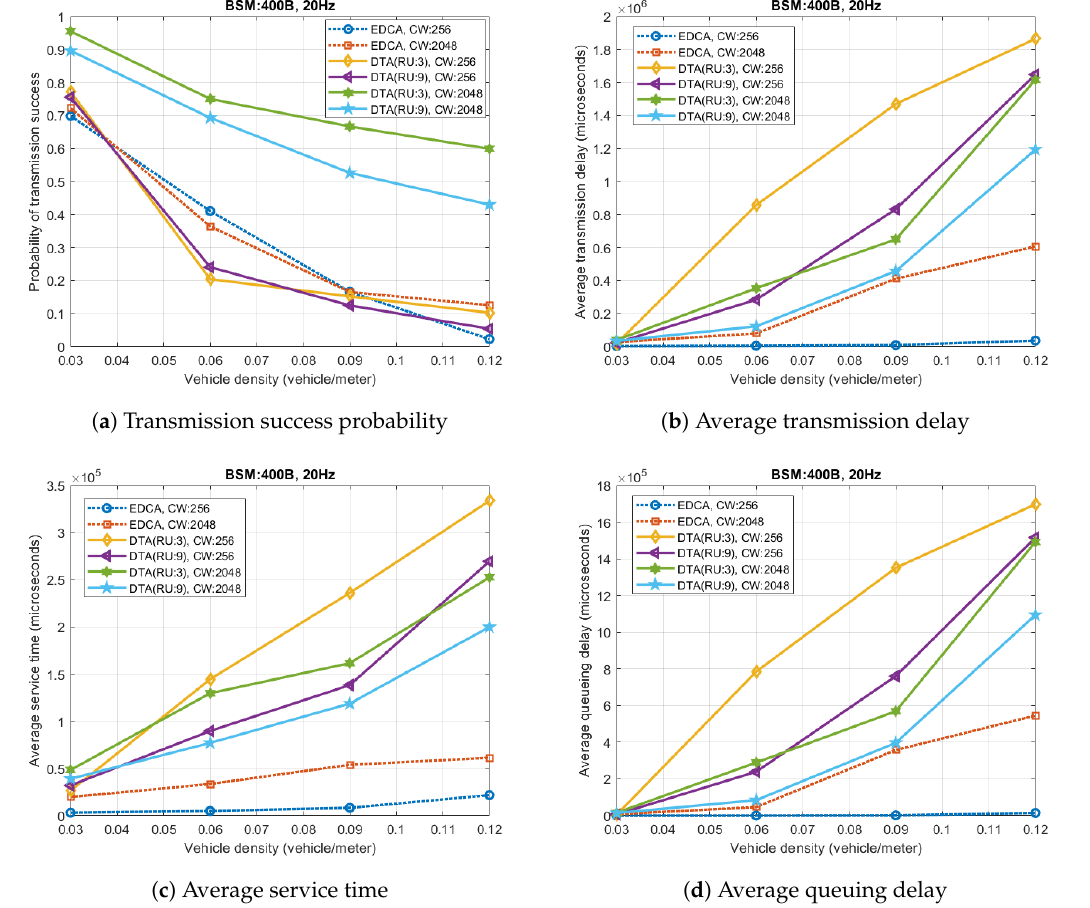
Figure 9. Performance statistics in heavy data